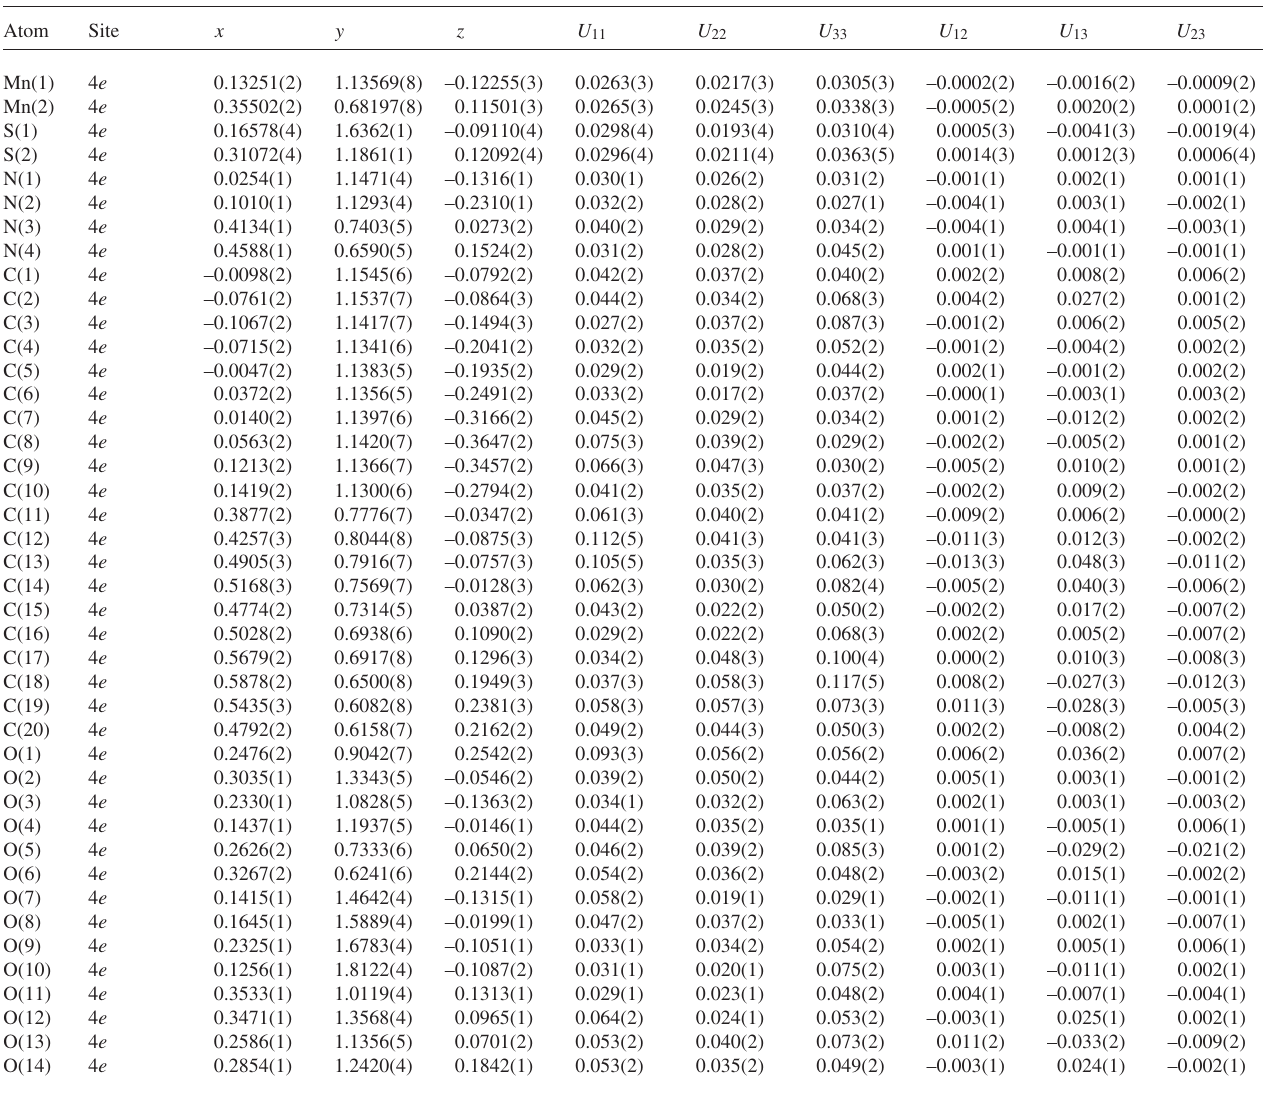
Table 3. Atomic coordinates and displacement parameters (in Å 2 )